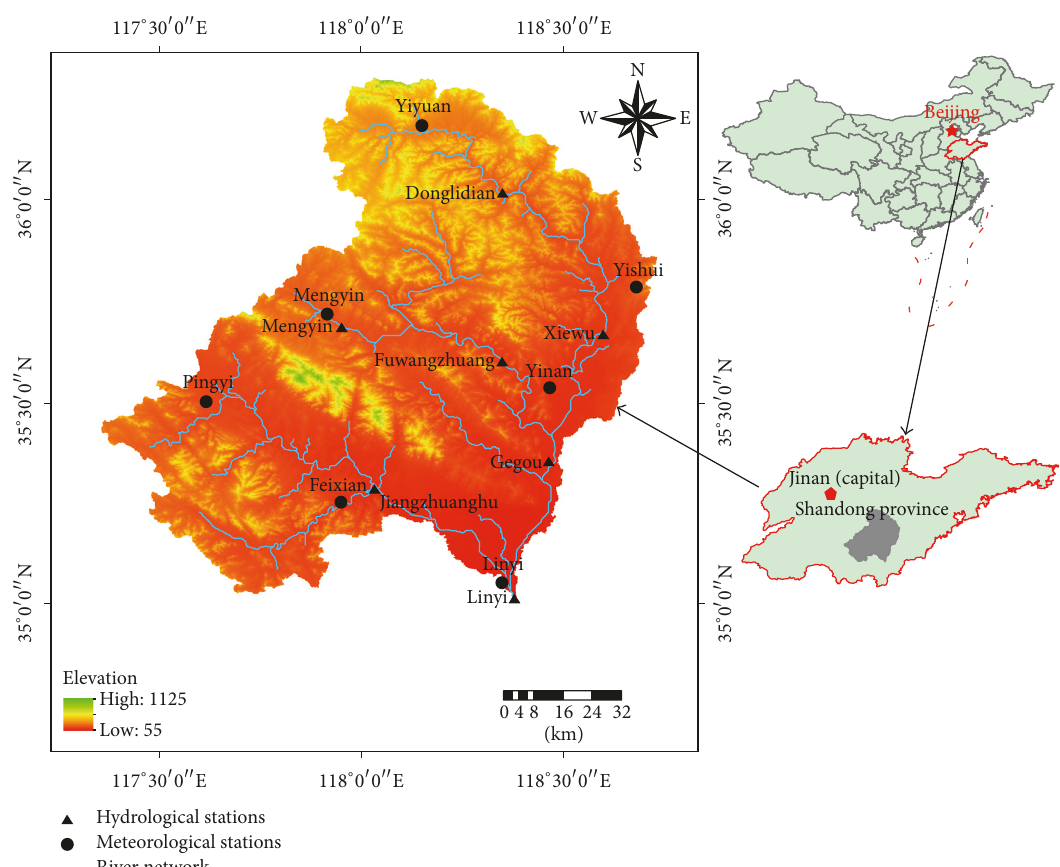
Figure 1: Sketch map of study area, hydrological and meteorological